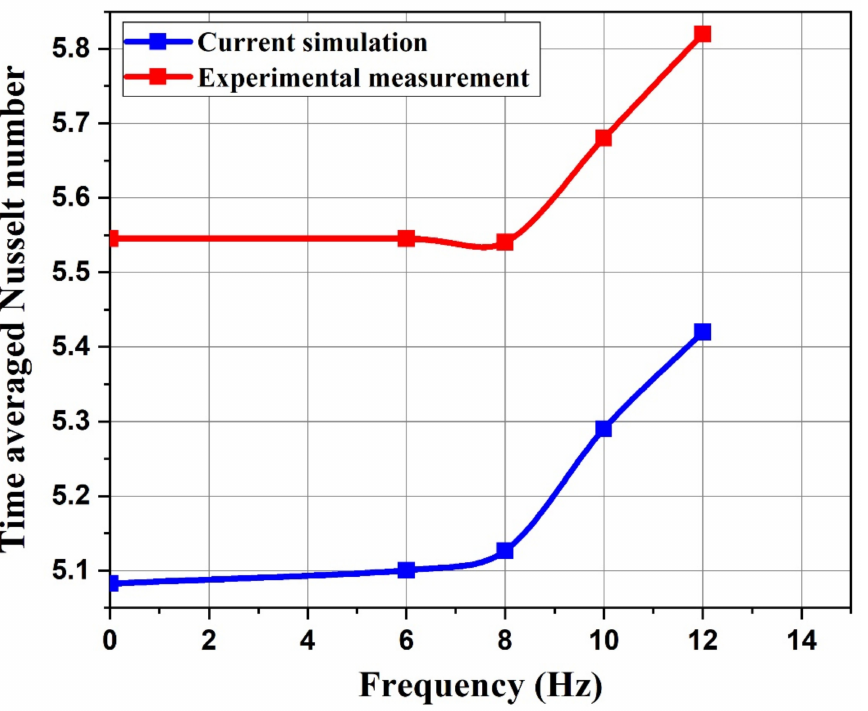
Figure 6. Time-averaged Nusselt number validation against experimental measurements of Najim, et al. [37].